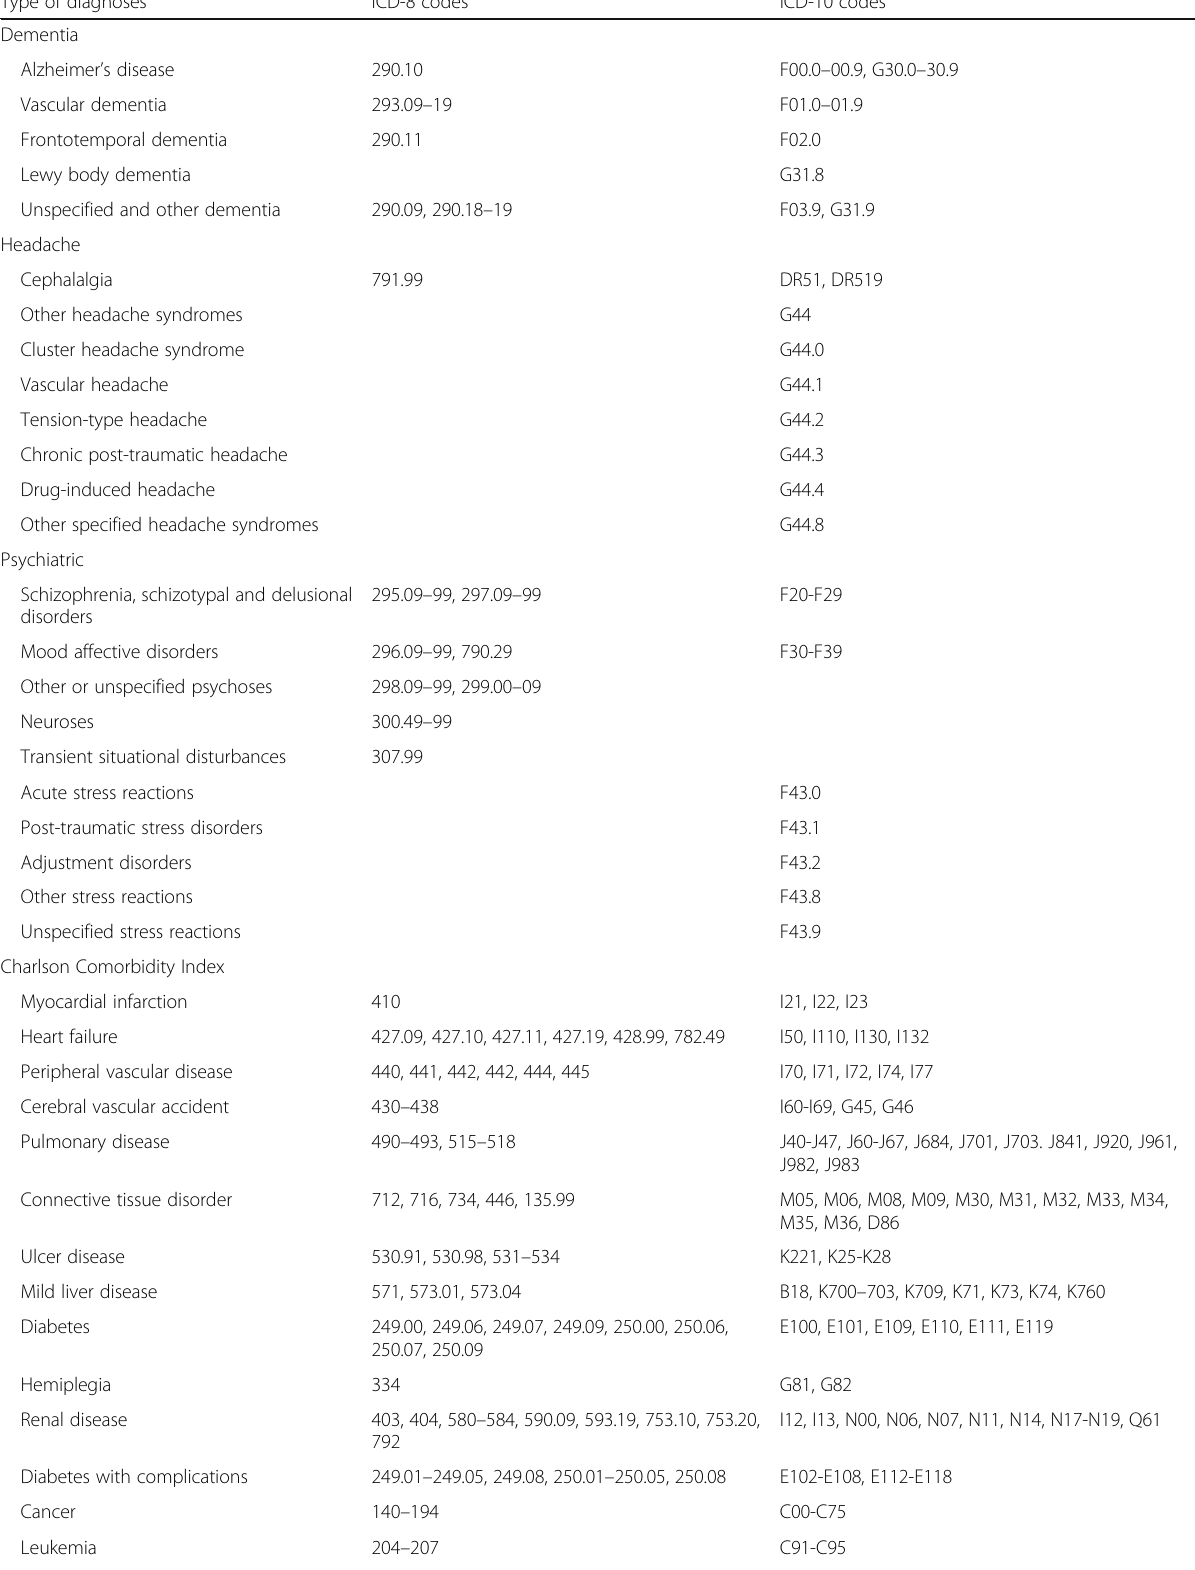
Table 1 Diagnostic codes for dementia and included covariates from the International Classification of